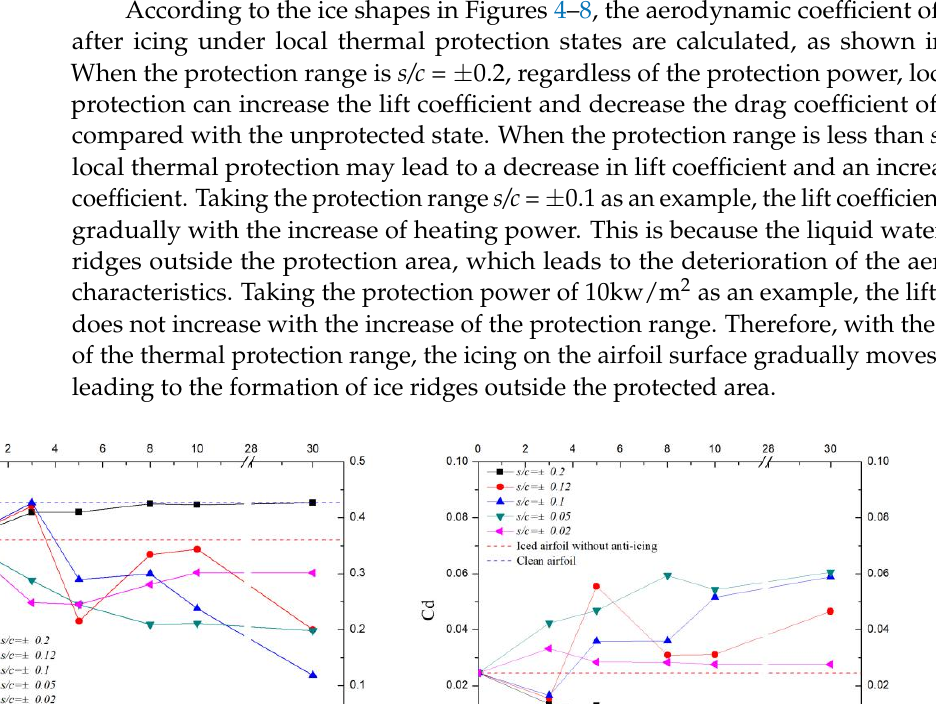
Figure 8. Icing characteristics with protection range of s / c = ±0.02: ( a ) Ice shapes; ( b )Ice thickness.